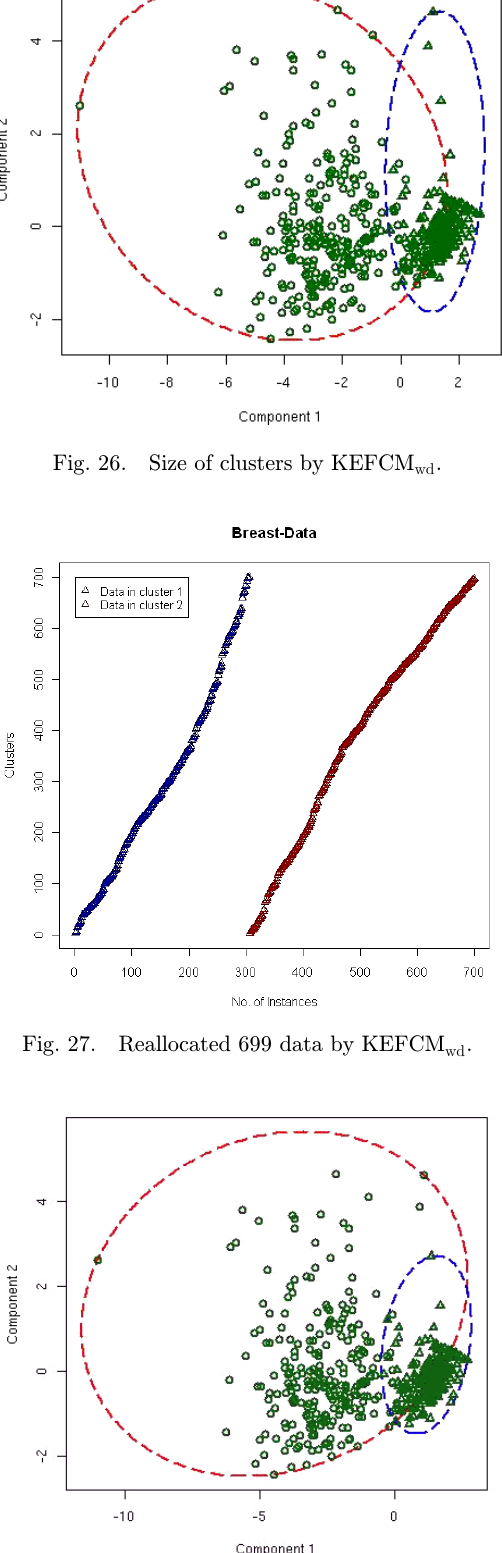
Fig. 28. Size of clusters by KFCM nt